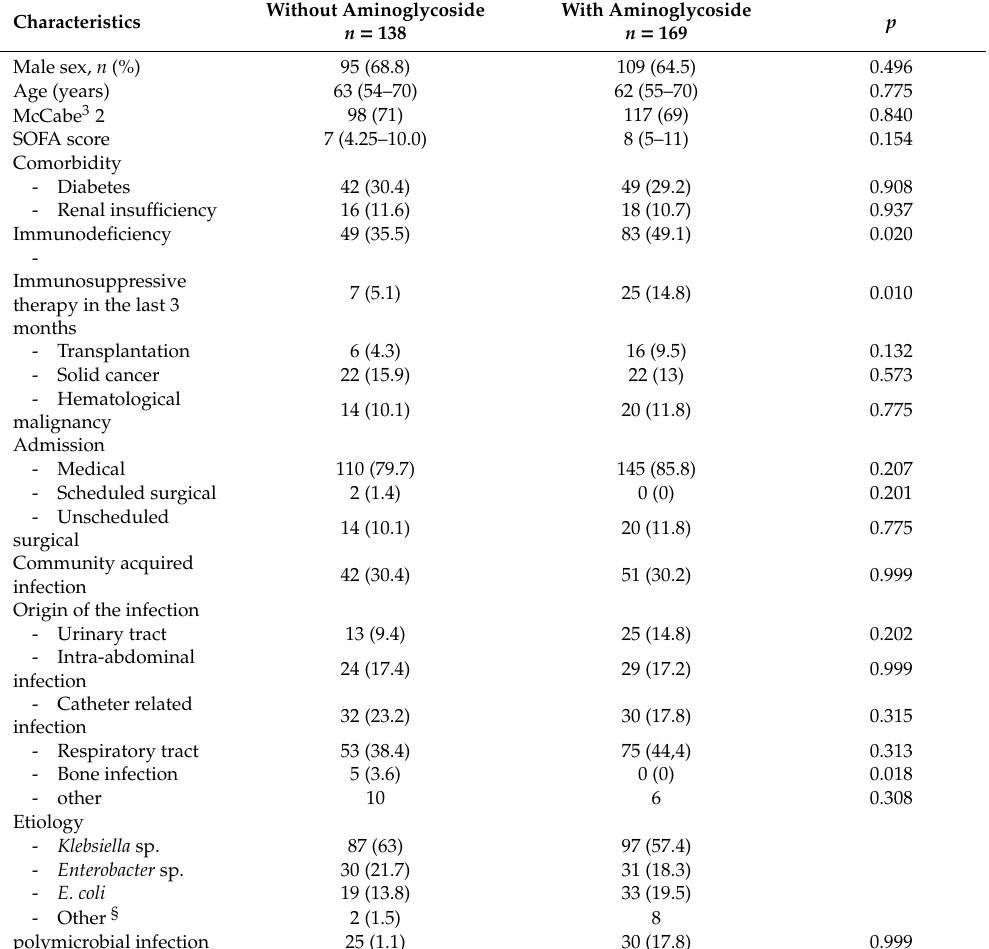
Table 1. Demographic and clinical characteristics of our patients depending on aminoglycoside